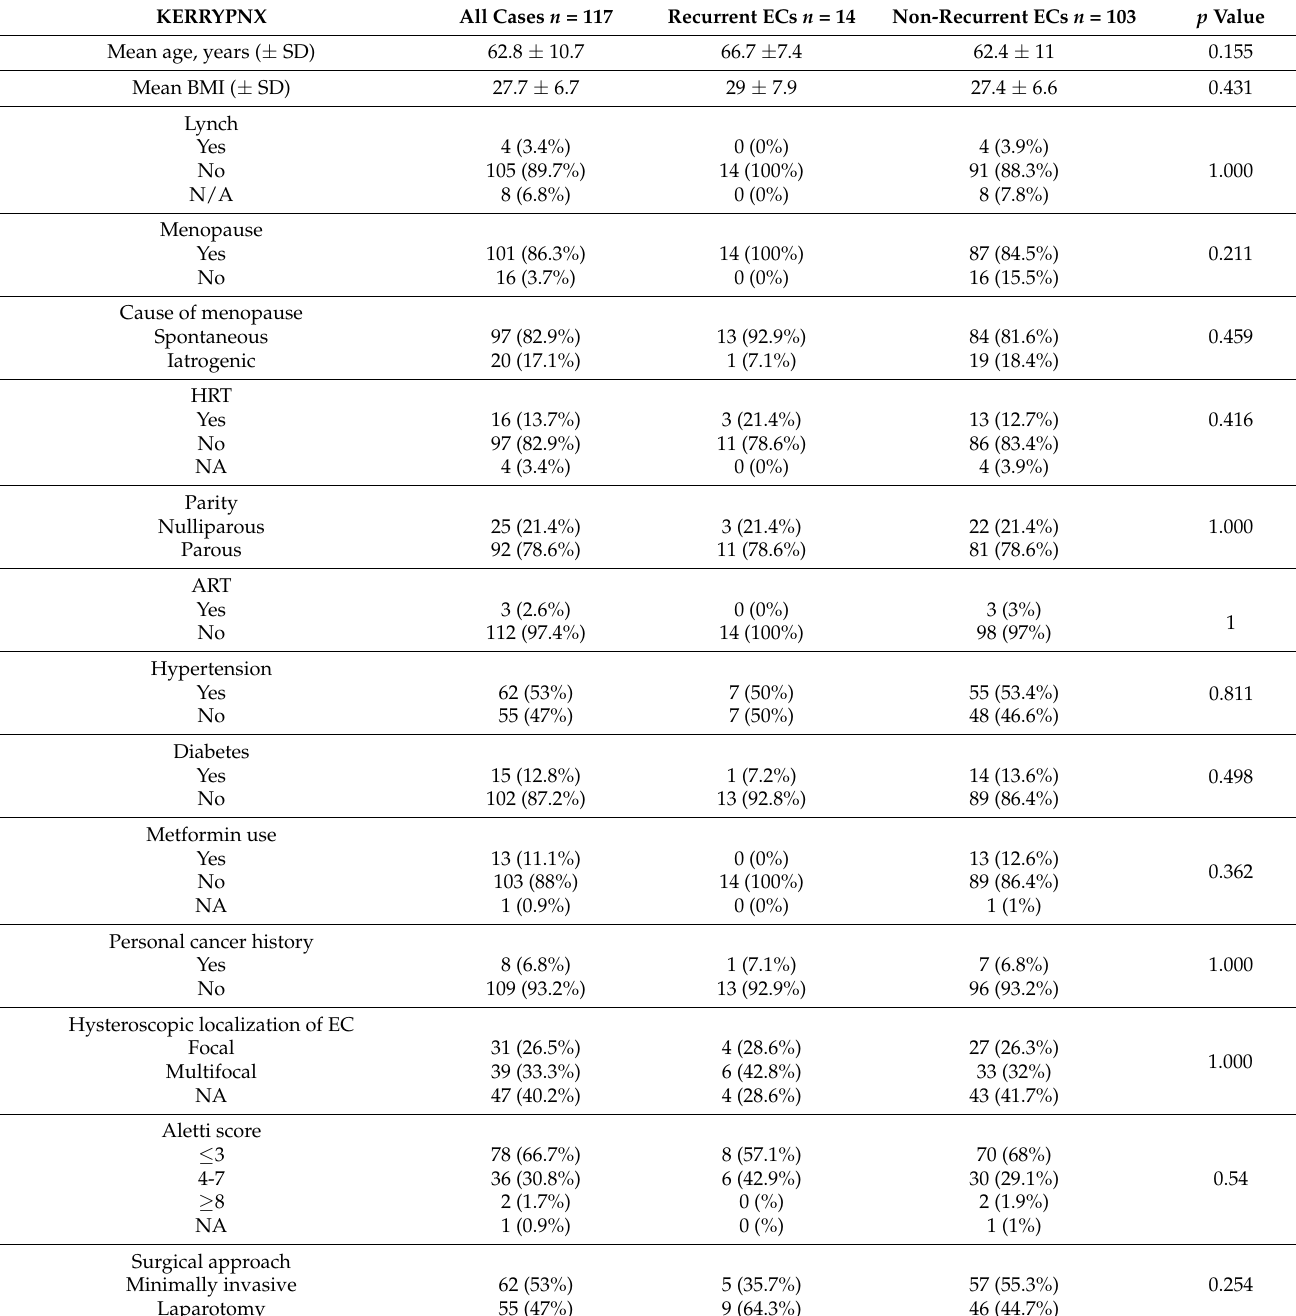
Table 1. Bologna study cohort: patient, surgery, and molecular characteristics of recurrent and non-recurrent EC